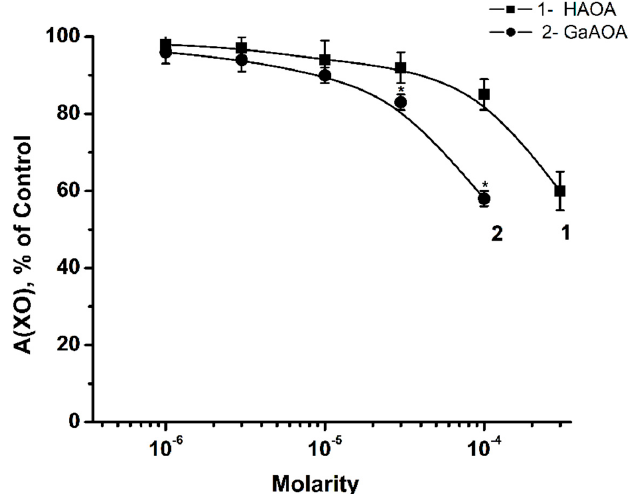
Figure 3. Effect of HAOA (curve 1) and GaAOA (curve 2) on the activity of the XO in the formation of uric acid (UA) from xanthine at pH of 7.45, according to UV detection of the uric acid. Data = mean ± SD ( n = 5). *, statistically significant difference from HAOA ( p < 0.05).